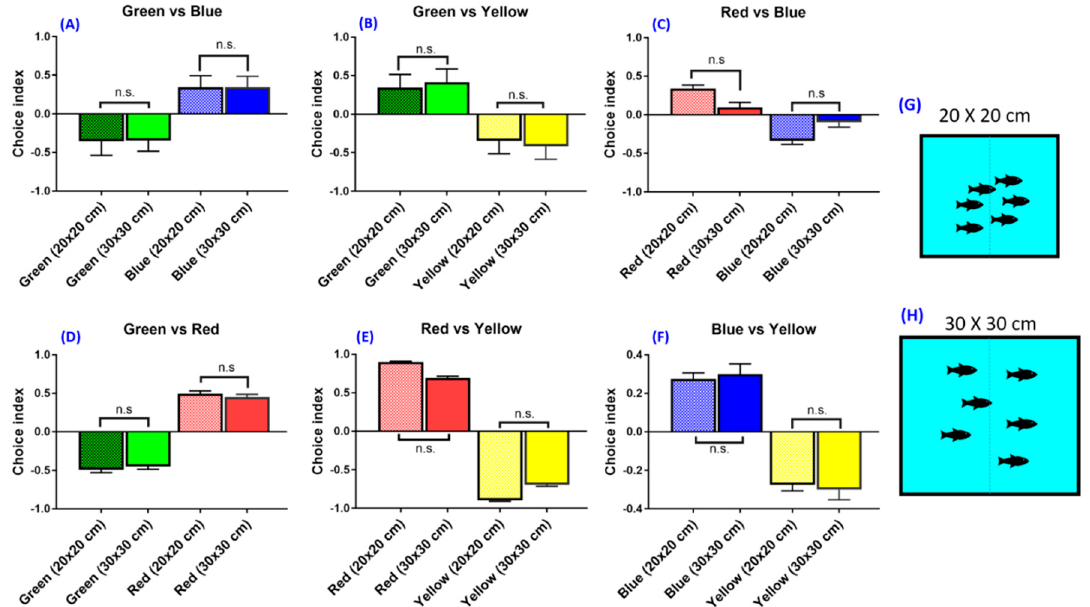
Figure 3. The effect of different tank sizes on the zebrafish swimming activity choice index. ( A ) Green vs. blue combination, ( B ) green vs. yellow combination, ( C ) red vs. blue combination, ( D ) green vs. red combination, ( E ) red vs. yellow combination, ( F ) blue vs. yellow combination. ( G , H ) Schematics showing two settings with different fish-to-tank ratios for assessment of the fish density effect. The data are presented as mean ± SEM, n = 24 for each group. The difference was tested by one-way ANOVA. n.s. = non-significant.